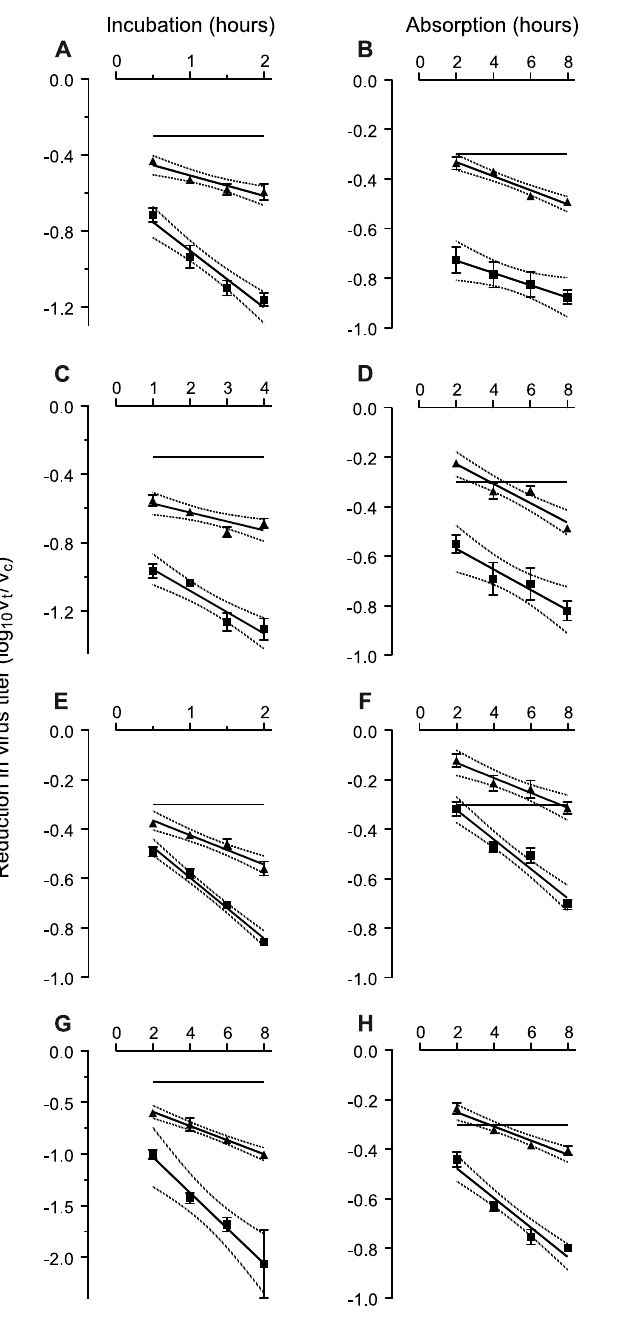
Figure 2. Reductions in infectious titer following exposure of HIV-1 SF162 to sera from immunized rhesus macaque. Sera are taken two weeks before challenge. Reductions in infectious virus are calculated as ratio of the titer (V t ) at time t for the virus exposed to serum from an immunized macaque divided by the titer (V c ) at the same time for a control serum. The ratio is transformed to log 10 (V t /V c ). Incubation and absorption phases are measured in hours. Data are displayed as means with standard errors. Plots are regression lines with 95% confidence band. Solid squares: 1 in 20 serum dilution; solid triangles: 1 in 50 serum dilution. Expected ratio of neutralization rates is the ratio of the serum concentrations within an individual assay: 2.5. A , Incubation plots of serum from protected macaque in treatment group 3.2 (Ratio=2.79; p=0.0004189); B , absorption plots from same macaque (Ratio=0.88; p=0.7321); C , Incubation plots from protected macaque in treatment group 4.1 (Ratio= 2.40; p = 0.01276); D ,